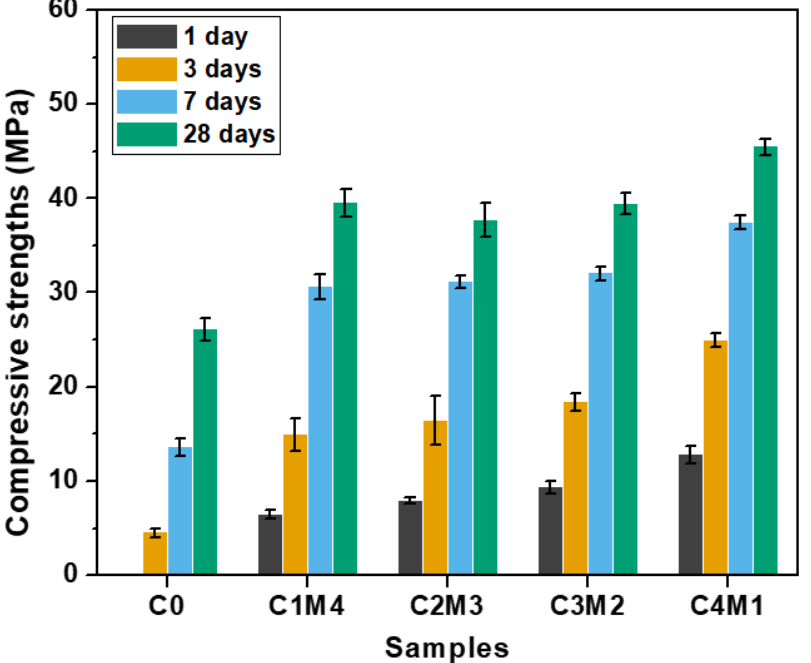
Figure 4. Compressive strengths of the Na 2 CO 3 -activated slag binders modified with Ca(OH) 2 and Mg(OH) 2